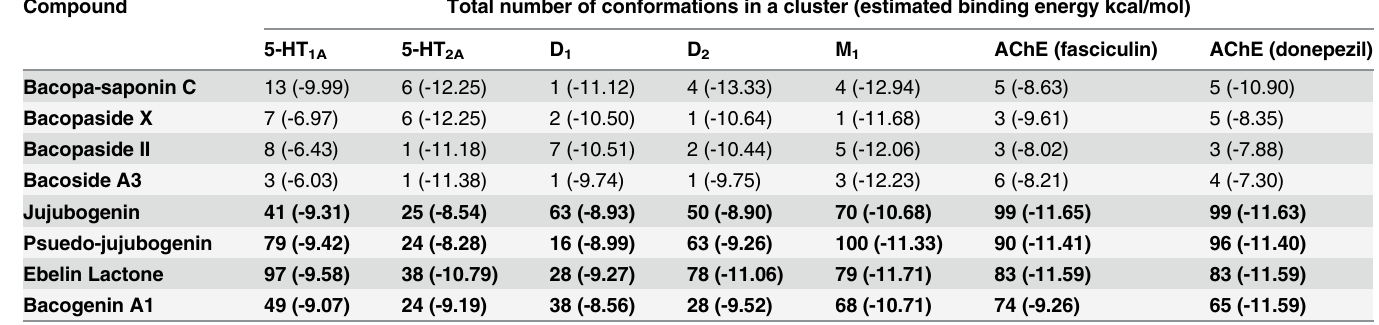
Table 2. Total number of conformations in a cluster and binding energy of compounds for 5-HT 1A , 5-HT 2A , D 1 , D 2 and M 1 receptors and AChE (in complex with fasciculin or donepezil) enzyme. Compound Total number of conformations in a cluster (estimated binding energy